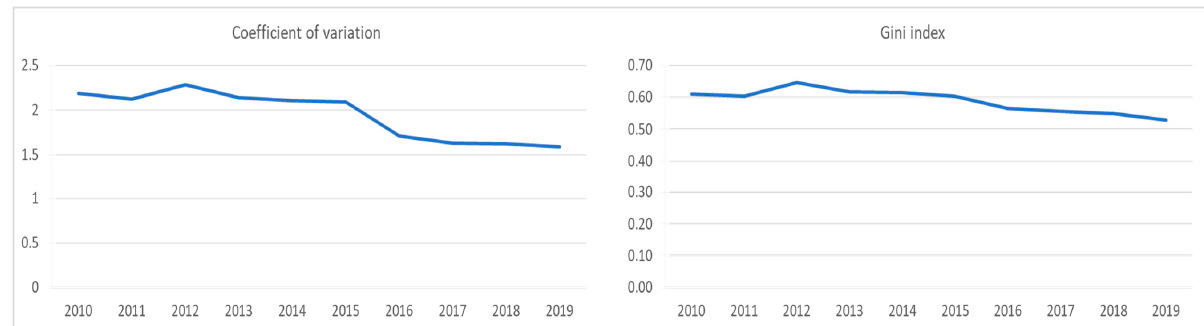
Figure 7. Spatial cluster analysis of urban industrial land in the YRD.